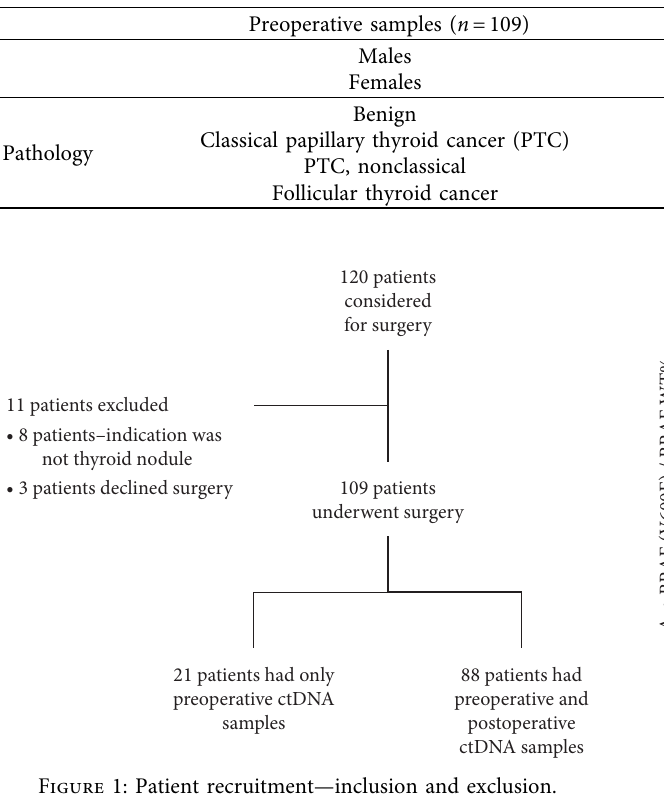
Table 1: Preoperative patient characteristics.